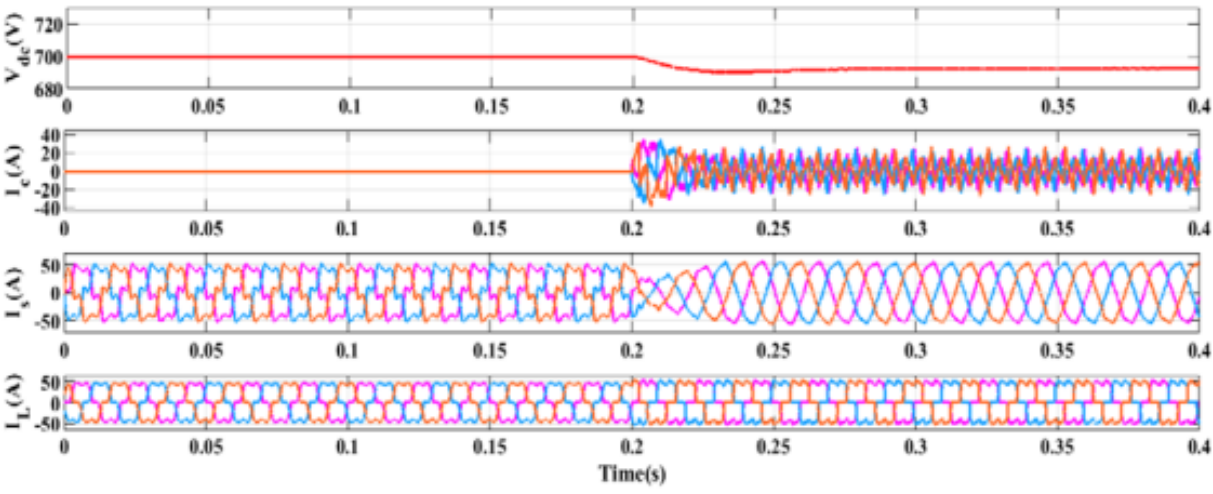
Figure 20. The behavior of Icos θ -based DSTATCOM with induction heating-based non-linear